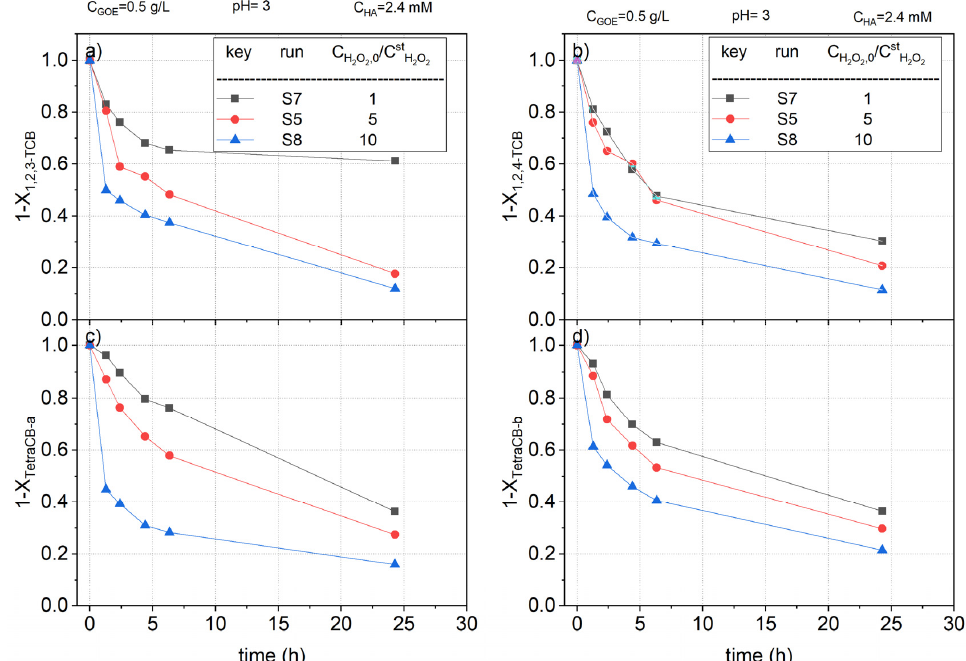
Figure 11. Remaining fractional concentration of ( a ) 1,2,3-trichlorobenzene ( 1 − X 1,2,3 − TCB ); ( b ) 1,2,4-trichlorobenzene ( 1 − X 1,2,4 − TCB ); ( c ) tetrachlorobenzene-a ( 1 − X TetraCB − a ); and ( d ) tetrachlorobenzene-b ( 1 − X TetraCB − b ) vs. reaction time using different doses of hydrogen peroxide